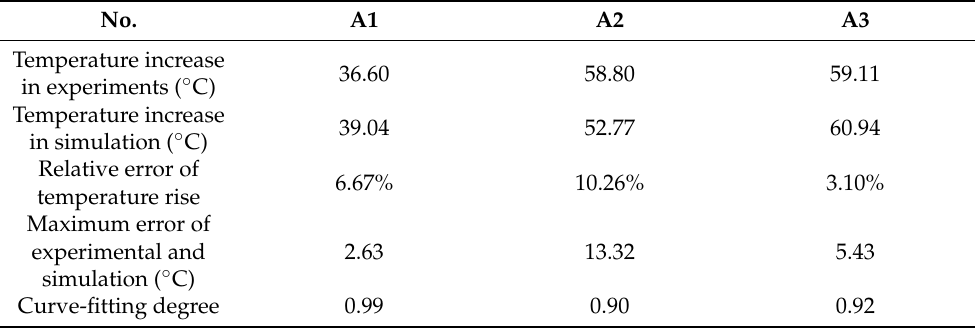
Table 6. Comparison of temperature variations at simulation and experimental measurement